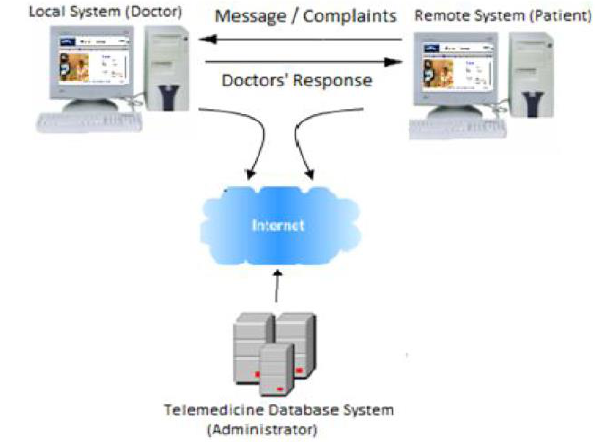
Figure 3. Simplified Framework for Telemedicine System (Olayinka et al.